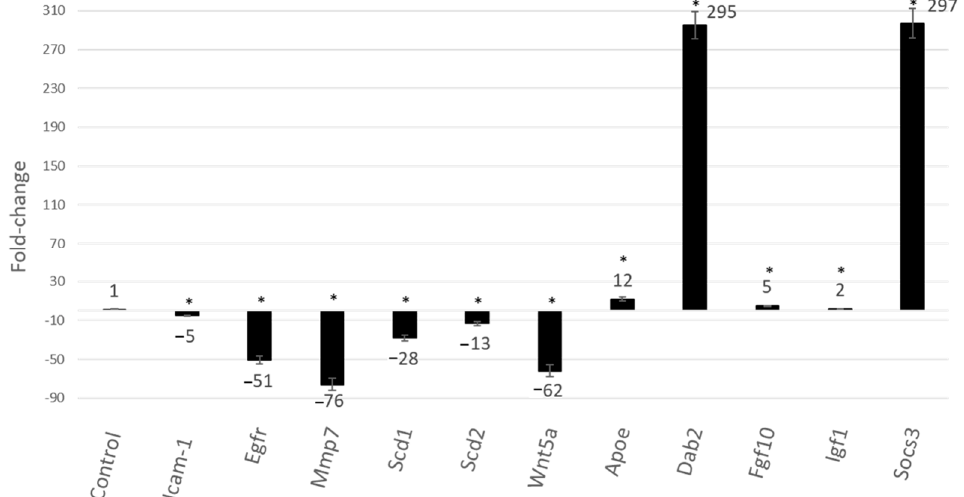
Figure 3. Gene expression analysis of LPS-activated peritoneal macrophage treated with (3 S )-vestitol 0.55 µ M. Statistical Analysis: Student’s t-test was conducted to assess statistical significance between vehicle-control and V55 group utilizing mean CT values obtained from the triplicate samples ( p <